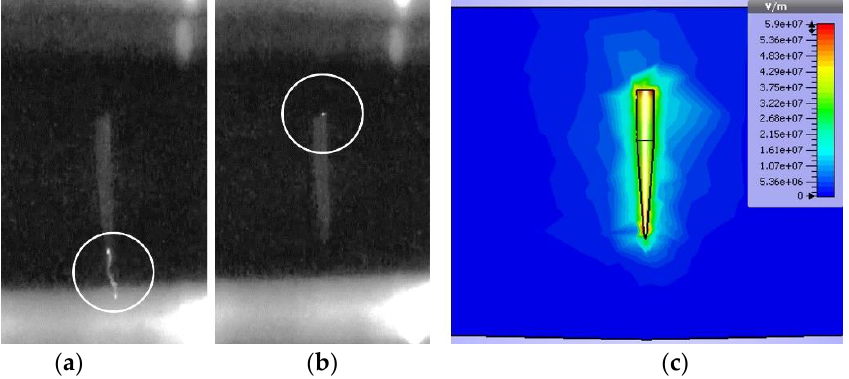
Figure 13. Corona for 10 mm of particle size and d = 5 mm at voltage stress of 71 kV: ( a ) corona at the bottom of particle; ( b ) corona at the top of particle; and ( c ) simulation result of E -field distribution.